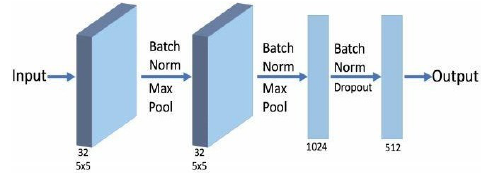
Fig. 3: Architecture of 2-layer baseline CNN